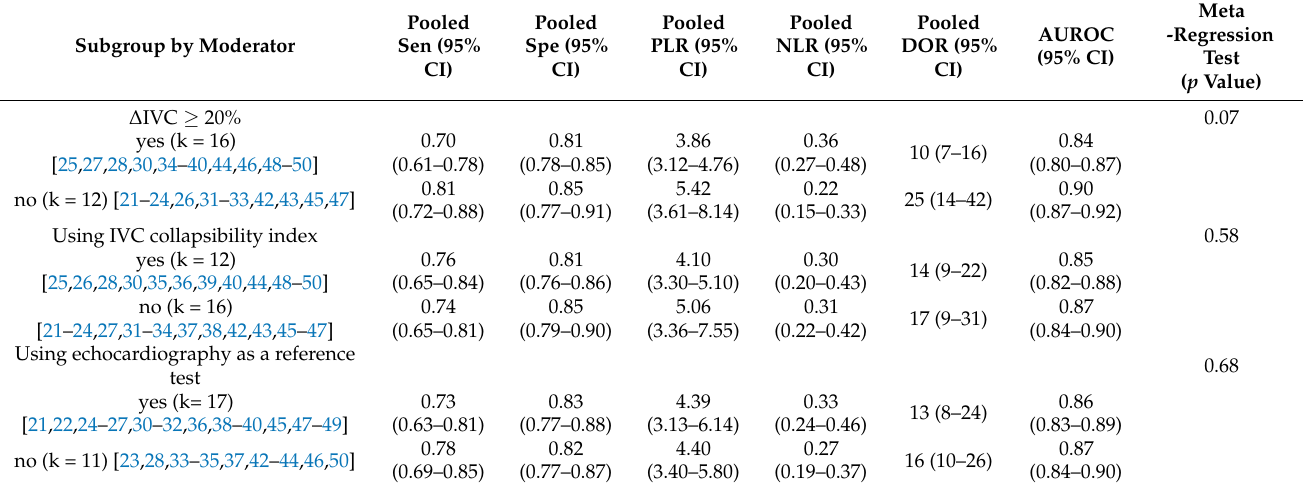
Table 3. Meta-regression and subgroup analysis of respiratory variability of IVC